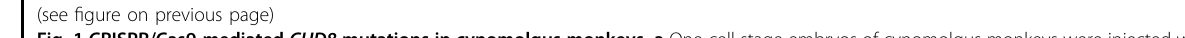
proteins to the loading control tubulin on multiple western blots veri fi ed that CHD8 mutations selectively increased glial proteins but not neuronal proteins (Fig. 2c). Glia are found in both gray and white matter,